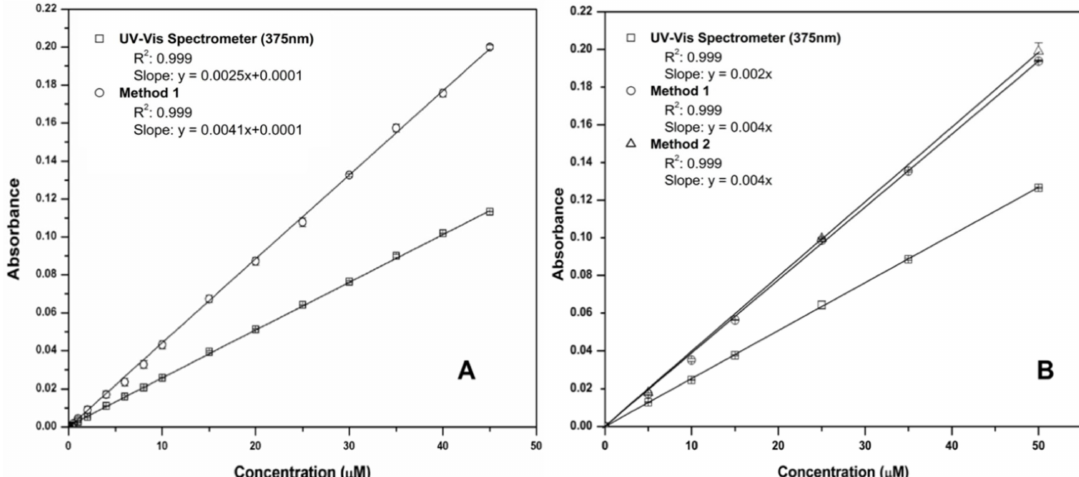
Figure 5. ( A ) Comparison of phosphate linear calibrations (0–50 µ M) obtained using the UV-Vis spectrophotometer and the fluidic chip detector with off-chip pre-mixed solutions (Method 1); ( B ) comparison of phosphate linear calibrations obtained using the UV-Vis spectrophotometer and the fluidic chip detector with automated sampling and on-chip mixing (Method 2). Method 1 (off-chip solution mixing) was also repeated with the same solutions for comparison. The excellent precision is evidenced by masking of error bars (standard deviations for n = 10 replicate measurements) by the point